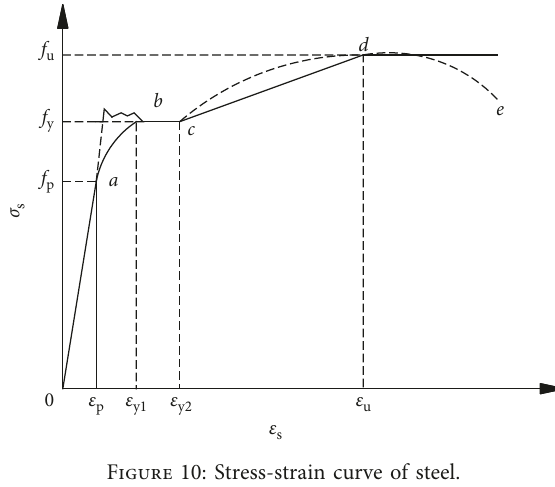
Figure 11: Stress-strain curve of core RSC.